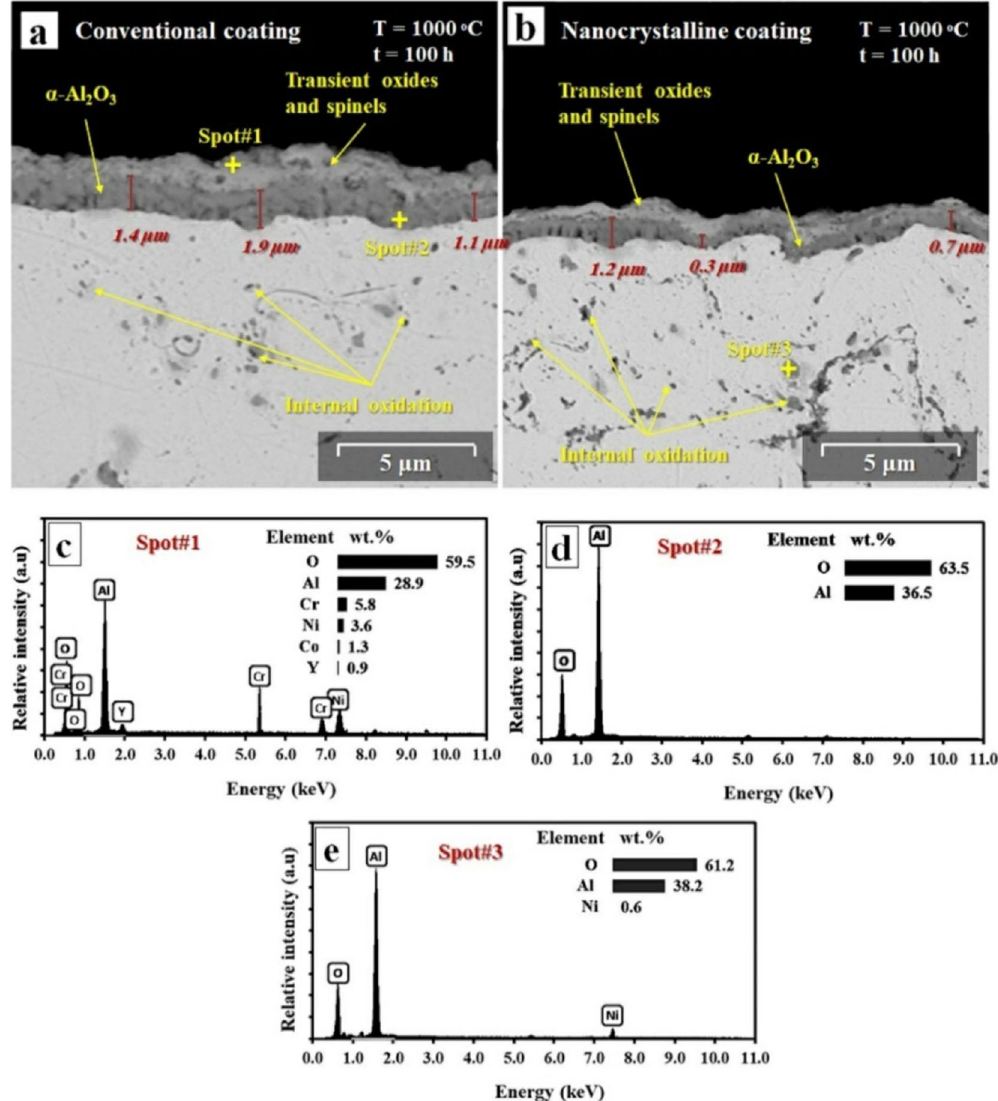
Figure 15. Backscattered FESEM images of the ( a ) conventional MCrAlY and ( b ) nanocrystalline MCrAlY coatings after 100 h of the short-term exposure at 1000 °C, ( c – e ) EDX results of the specified spots for the oxidized